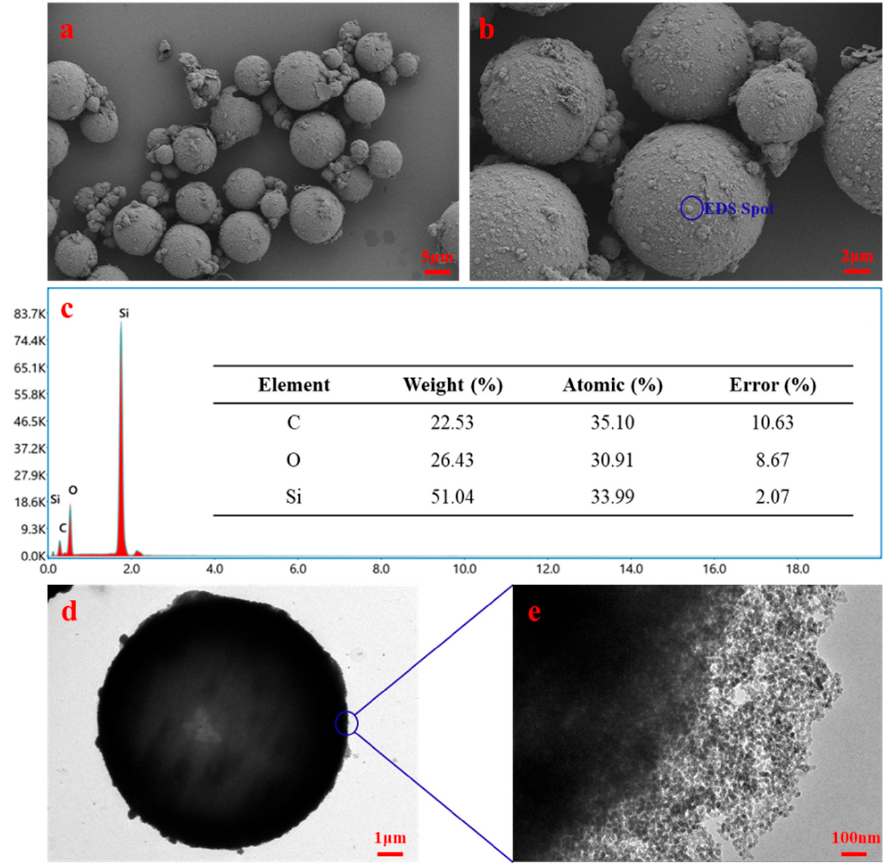
Figure 4. SEM photos (a,b), EDS spectrum (c), and TEM photos (d,e) of microcapsules.